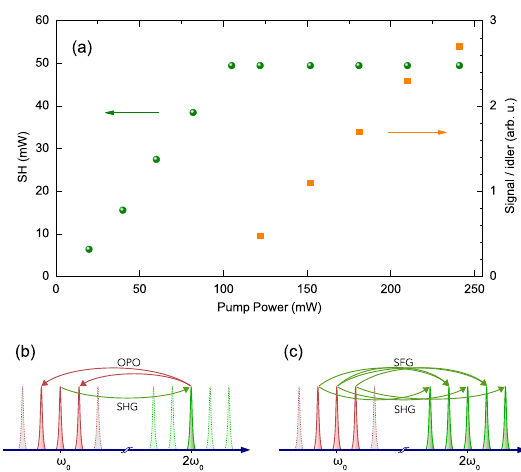
Figure 3: (a) Second harmonic and intracavity parametric power as a function of the pump power. When the pump power exceeds 100 mW the SH power clamps and new parametric sidebands appear with increasing power. (b) Schematic representation of second-harmonic generation with a cascading OPO giving rise to a signal-idler pair around the fundamental frequency, oscillat- ing in symmetrically displaced cavity resonances. (c) The multiple subharmonic components, in turn, lead to thresholdless, multiple second-harmonic and sum-frequency mixing processes, eventually culminating in a double comb emission.